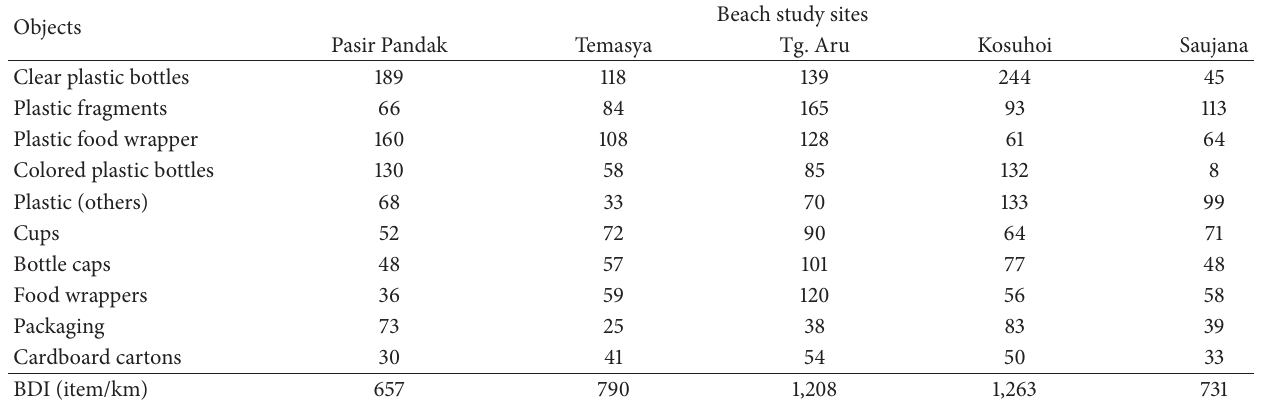
Table 3: Ten most numerous objects (item/km) found and BDI at the study sites.